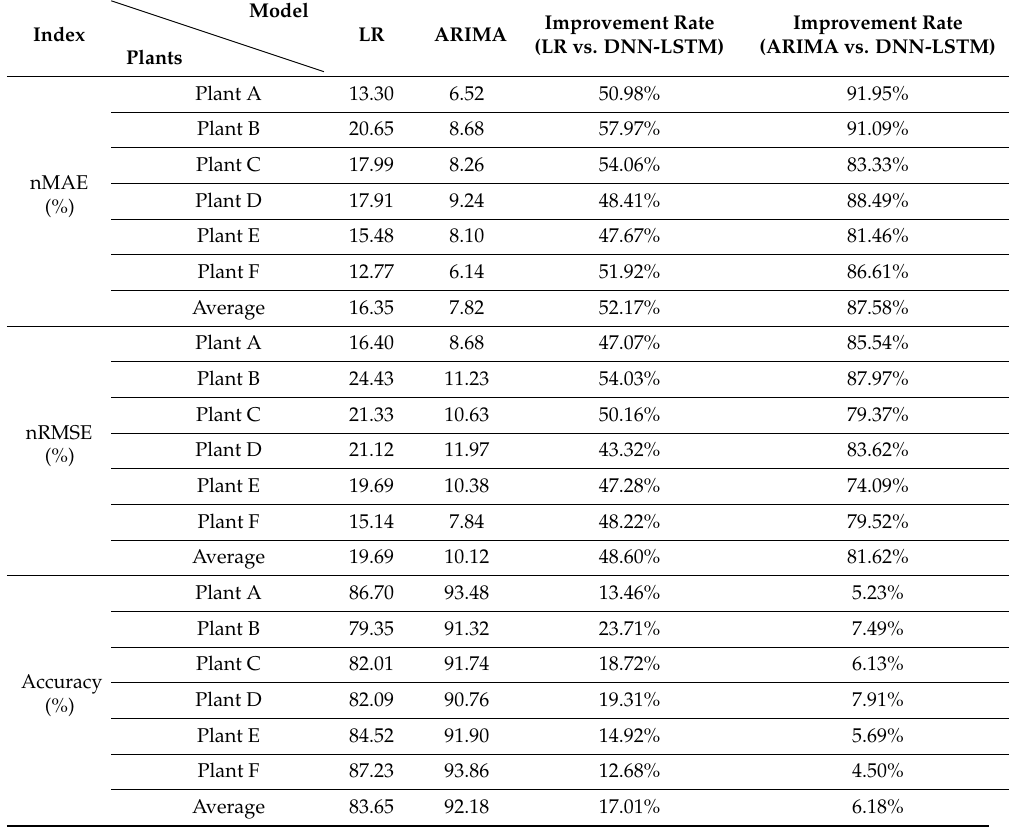
Table 12. Performance indexes of LR and ARIMR forecasting models.